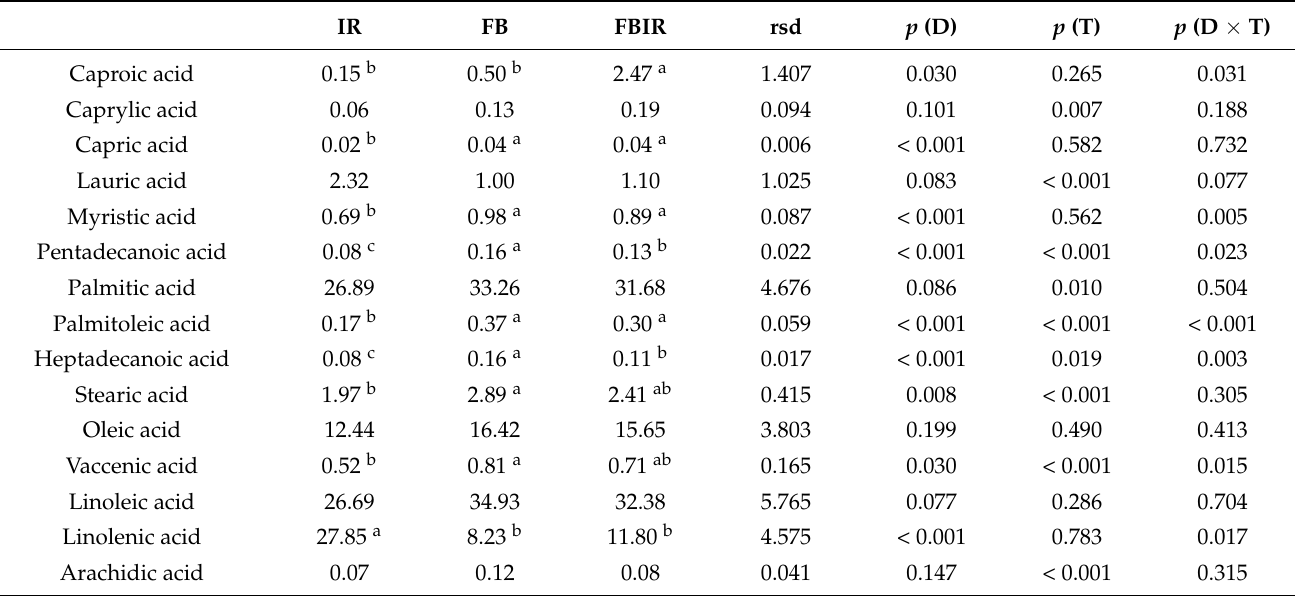
Table 5. Fatty acid profile (g 100 g − 1 FA) of total mixed rations (TMR) with Italian ryegrass, faba bean, and Italian ryegrass–faba bean intercropped silages.